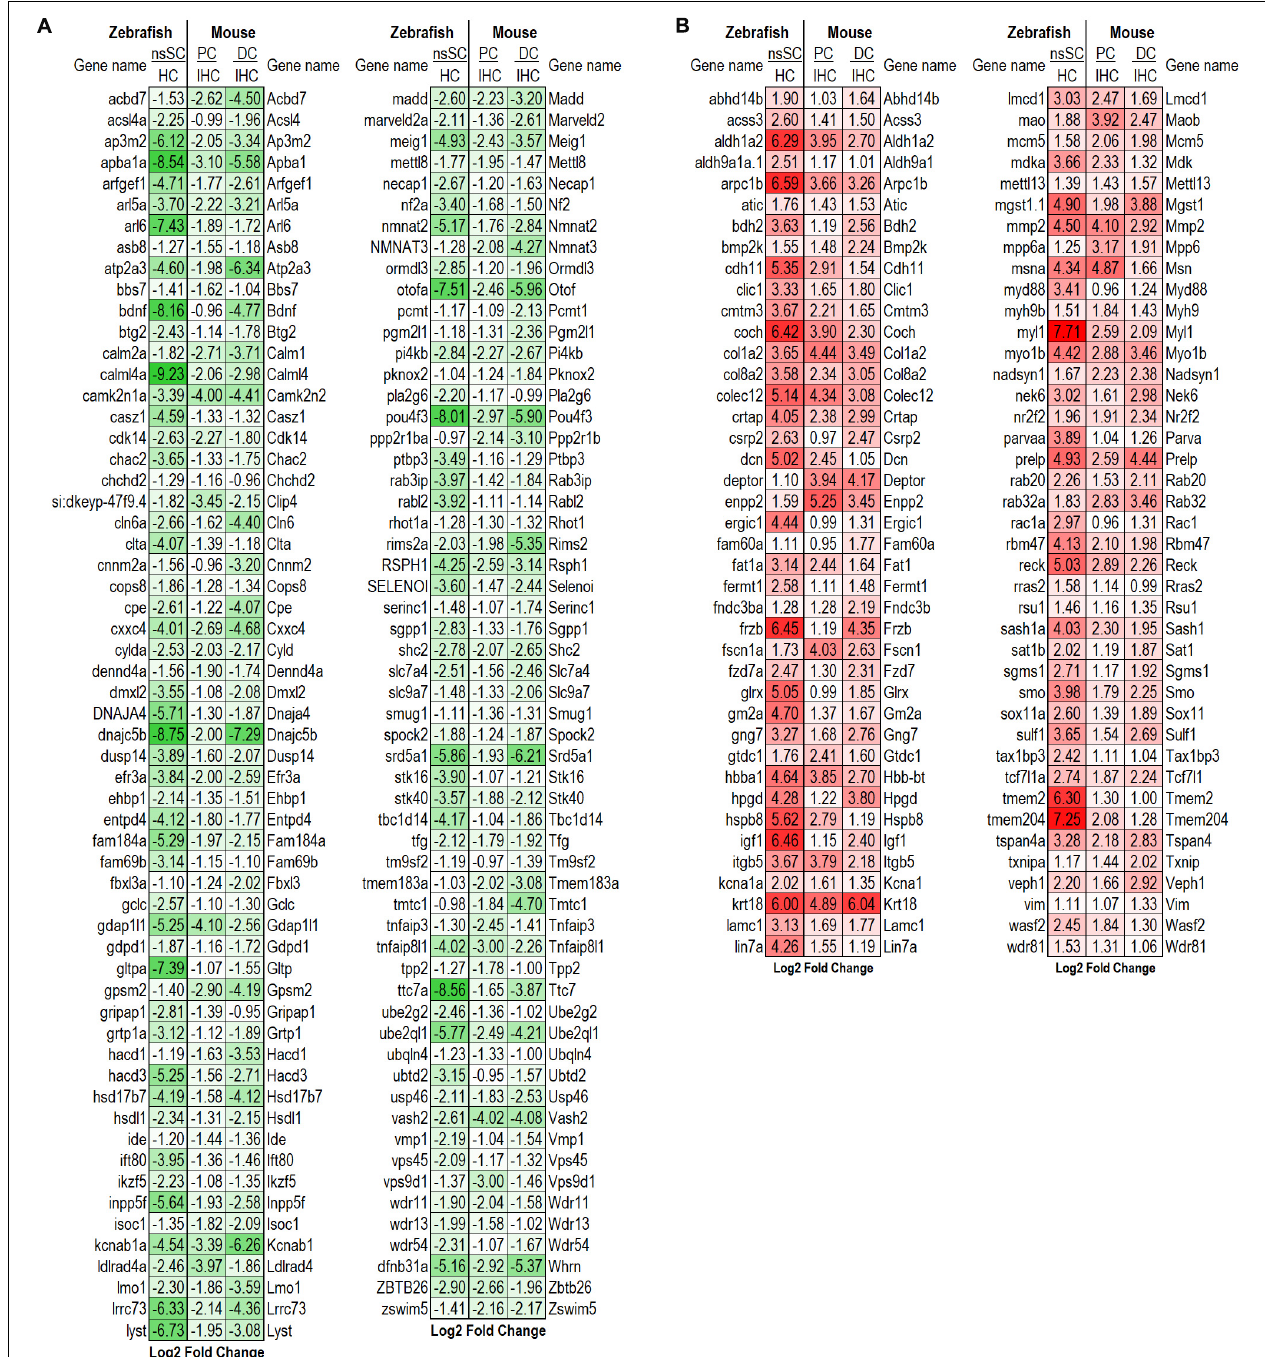
FIGURE 3 | Differentially expressed high-confidence gene orthologs in all zebrafish and mouse supporting cells. (A) Log2 fold change values of the 118 high-confidence gene orthologs commonly downregulated in zebrafish nsSCs and mouse supporting cells (corresponding mouse gene ortholog name on the right.) (B) Log2 fold change values of the 82 high-confidence gene orthologs commonly upregulated in nsSCs and mouse supporting cells. High confidence orthologs: ≥ 50% ID, ≥ 75 WGA and/or ≥ 75 GOC (see Materials and Methods).